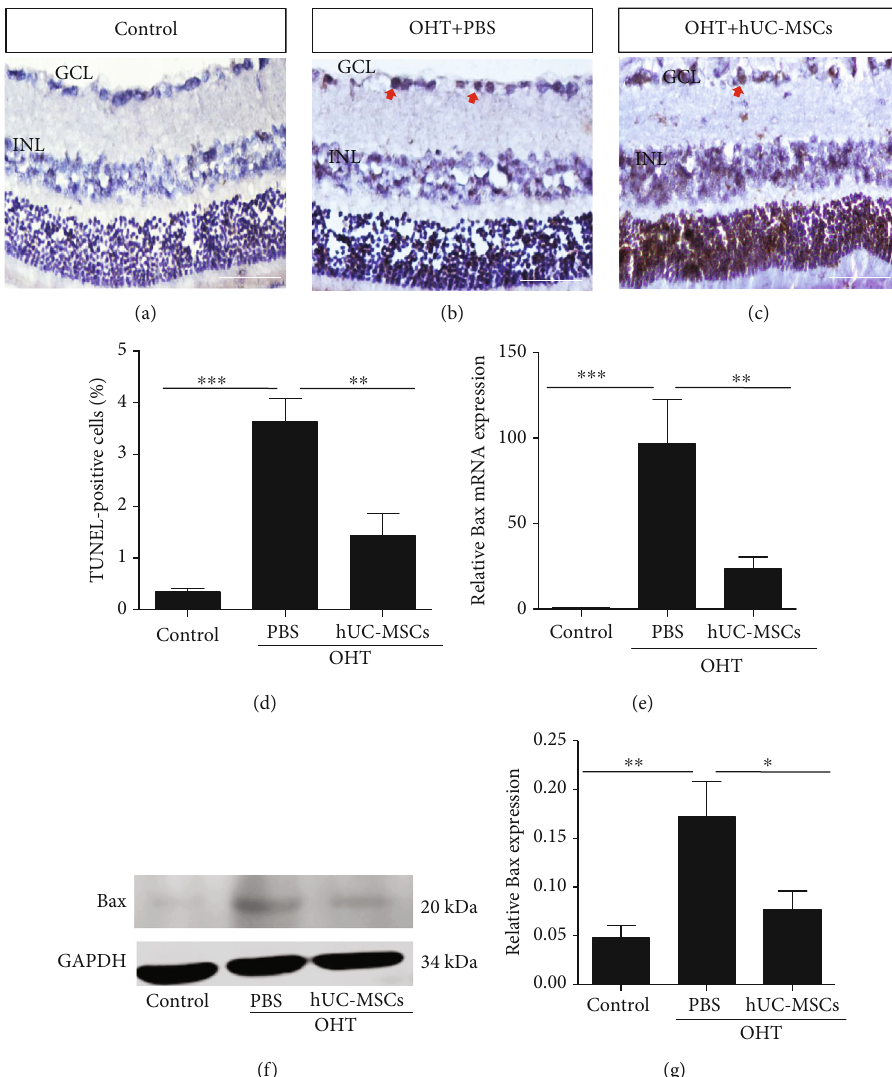
Figure 3: hUC-MSC transplantation decreases the apoptosis of retinal cells in OHT-induced rats. Two weeks after hUC-MSC injection. (a – c) Representative images of TUNEL staining in retinas from normal eyes, OHT+PBS eyes, and OHT+hUC-MSC eyes. The positive cells in the GCL and ILN of retinas were brown, and the arrow indicates positive TUNEL staining. (d) Quanti fi cation of TUNEL- positive cells ( n = 4/group ; ∗∗ P < 0 : 01 and ∗∗∗ P < 0 : 001 compared with one-way ANOVA with Turkey ’ s post hoc tests). (e) Relative Bax gene expression that was normalized to GAPDH in retinas from normal eyes, OHT+PBS eyes, and OHT+hUC-MSC eyes ( n = 4/group ; ∗∗ P < 0 : 01 and ∗∗∗ P < 0 : 001 compared with one-way ANOVA with Turkey ’ s post hoc tests). (f) Western blot analysis for Bax protein from normal eyes, OHT+PBS eyes, and OHT+hUC-MSC eyes. (g) Relative Bax protein expression that was normalized to GAPDH ( n = 4/group ; ∗ P < 0 : 05 and ∗∗ P < 0 : 01 compared with one-way ANOVA with Turkey ’ s post hoc tests). Scale bar: 100 μ